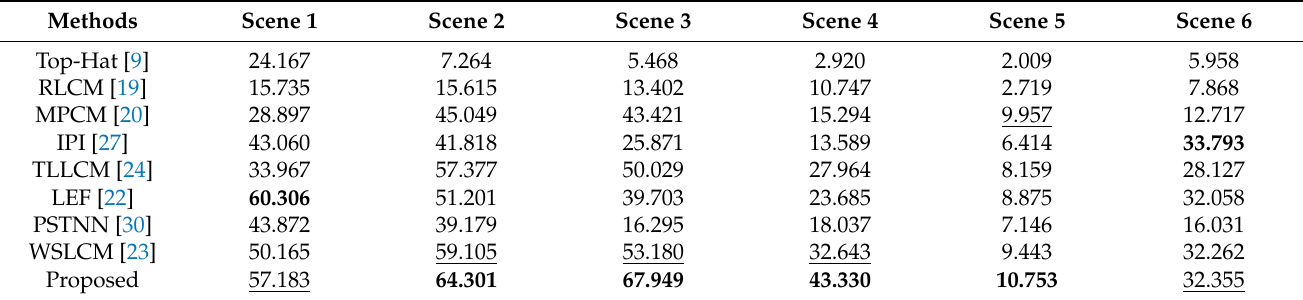
Table 4. Average BSF values of different methods in six real scenes.